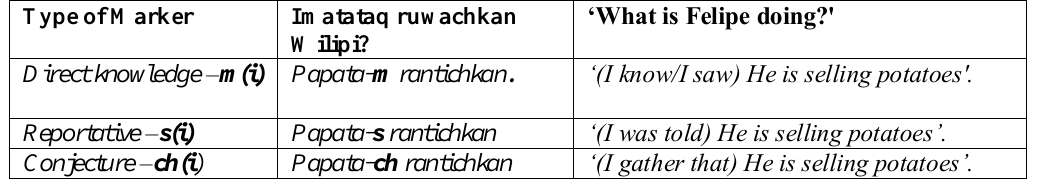
Table 3. Quechua evidential markers Type of